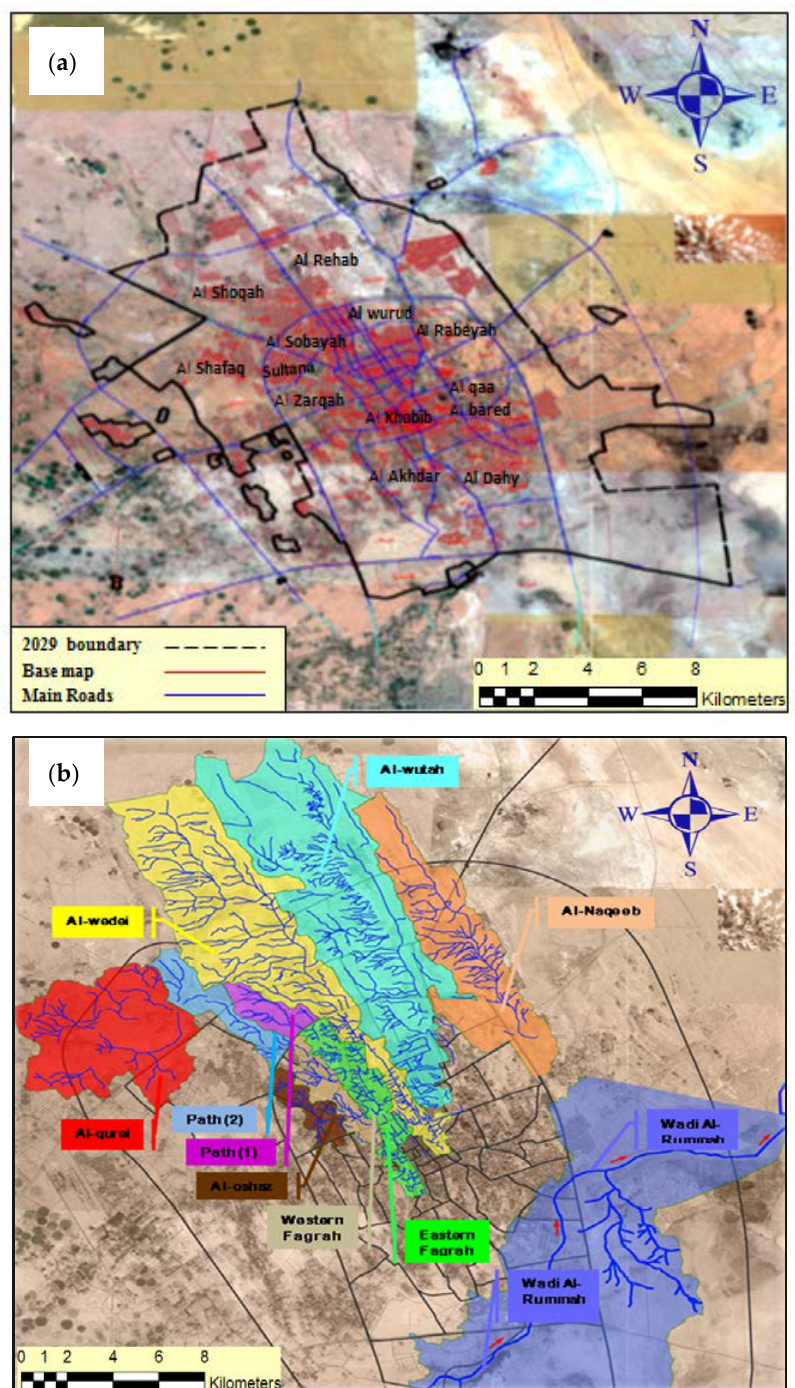
Figure 3. Geographical maps of the city of Buraydah, ( a ) base map with extended boundary; ( b ) Paths of stormwater